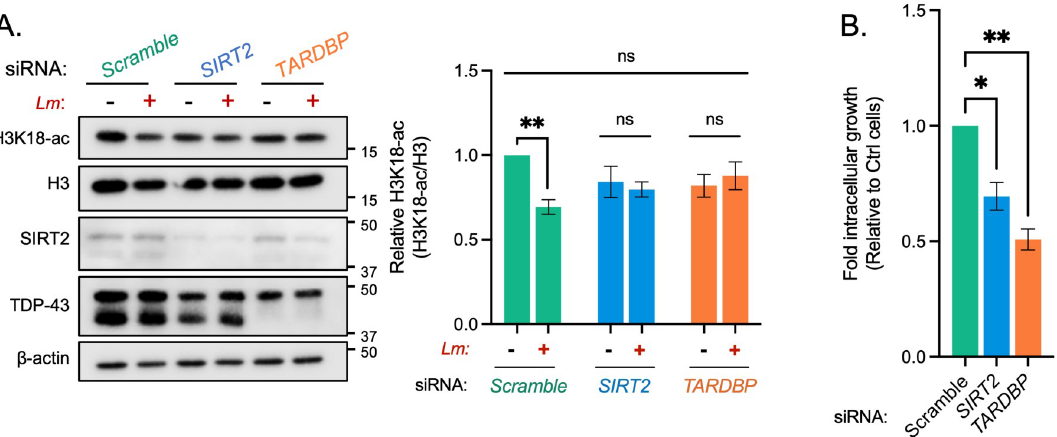
Fig 4. Silencing TDP-43 expression blocks H3K18 deacetylation and other SIRT2-related phenotypes during infection. (A) Representative image of H3K18 acetylation, SIRT2 and TDP-43 levels detected by immunoblotting (left) 6 hours post infection in uninfected HeLa ( − ) and L . monocytogenes –infected cells (+) transfected with stated siRNA. Quantification of H3K18 acetylation levels (right): band intensity of H3K18-ac and total H3 levels are normalised to β -actin followed by normalisation of H3K18-ac to total H3. Values are expressed as normalised band intensity relative to uninfected Scramble cells. Error bars represent SEM of four independent experiments. Statistical significance was determined by a Kruskal-Wallis test (ns = not significant, �� = p < 0.01). (B) Fold change of intracellular L . monocytogenes colony forming units during infection of HeLa cells transfected with stated siRNAs. Data are presented as fold-change in recovered intracellular CFU between 2.5 and 24 hours post infection relative to Scramble siRNA cells. Graph shows the mean ± SEM from three independent experiments. Statistical significance was determined by a Kruskal-Wallis test ( � = p < 0.05, �� = p < 0.01).